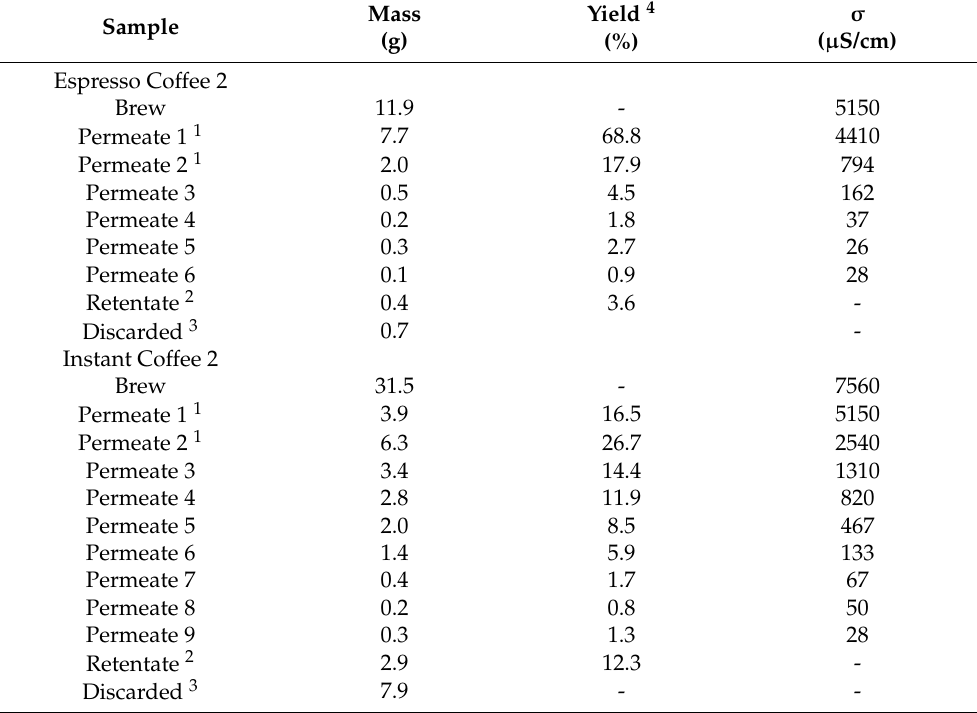
Table 2. Ultrafiltration data—mass, yield of recovery, specific extinction coefficients ( K mix,405 nm , K mix,280 nm , and K mix,325 nm ), and conductivity ( σ ) of espresso coffee 1 and instant coffee 1 brews and derived fractions. Mass Sample